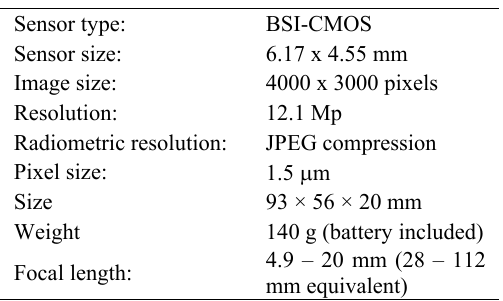
Table 1. Technical specifications of the paratrike.